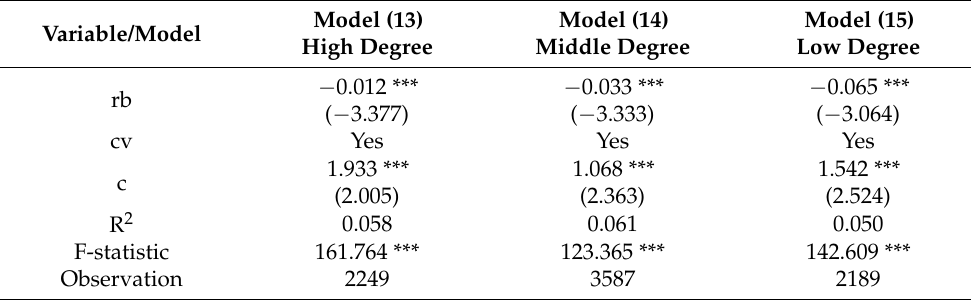
Table 8. Results of heterogeneous effect (marketization degree).